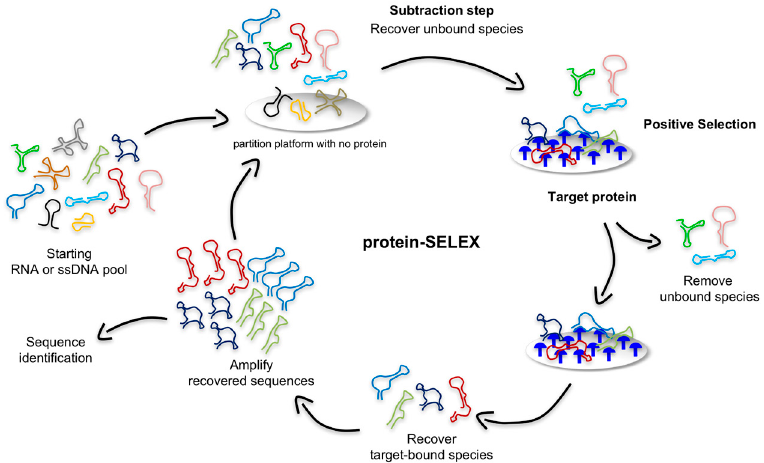
Figure 2. Schematic illustration of the protein-based SELEX. In a typical protocol, a subtractive step is first performed to remove nucleic acid sequences with significant affinity toward the partition platform used during the SELEX (e.g., beads, nitrocellulose filter, or chip-based approaches). The recovered unbound sequences are then incubated with the target protein (depicted in blue), and target-bound ligands are separated from the unbound population, recovered and amplified for the next SELEX round.